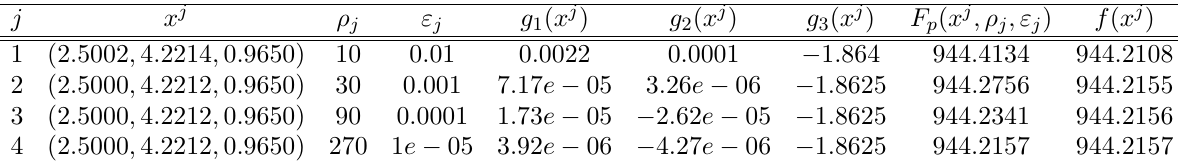
Table 3. Table of minimization process of the Problem 3.